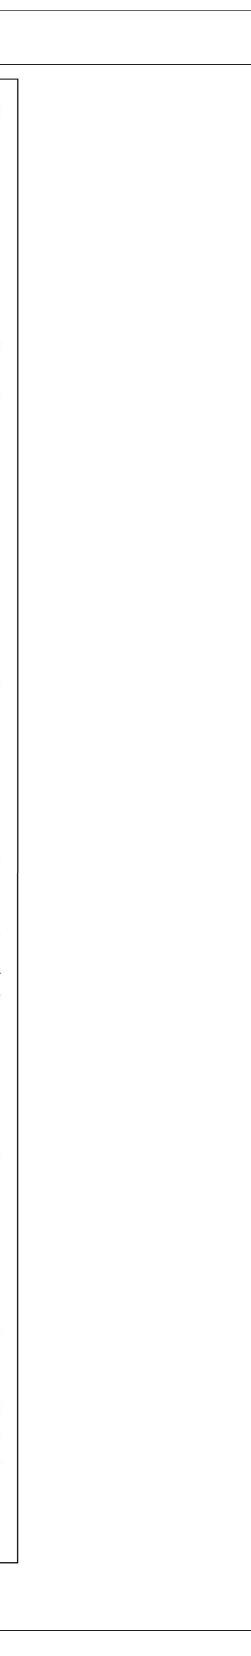
Frontiers in Research Metrics and Analytics |